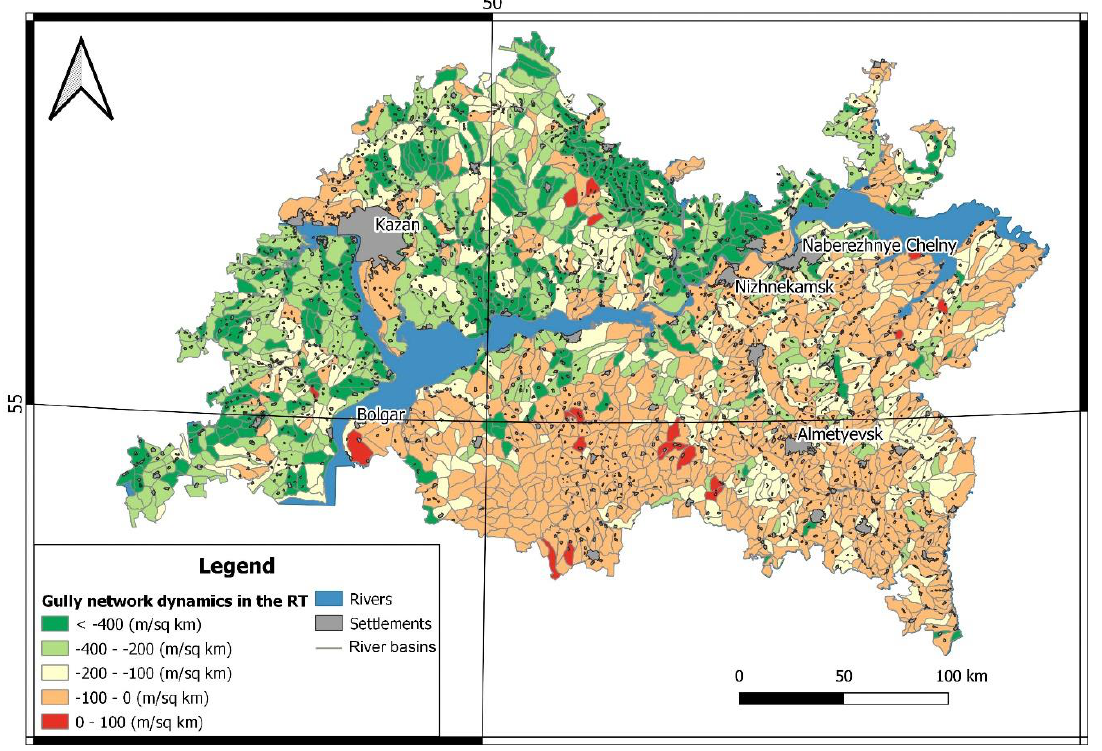
Figure 2. Dynamics of the gully network for the period 1970–2017 on the territory of the Republic of Tatarstan (RT) (“minus” means reduction of the dissection density (the total length of the entire gully network in the river basin, divided by its area)).